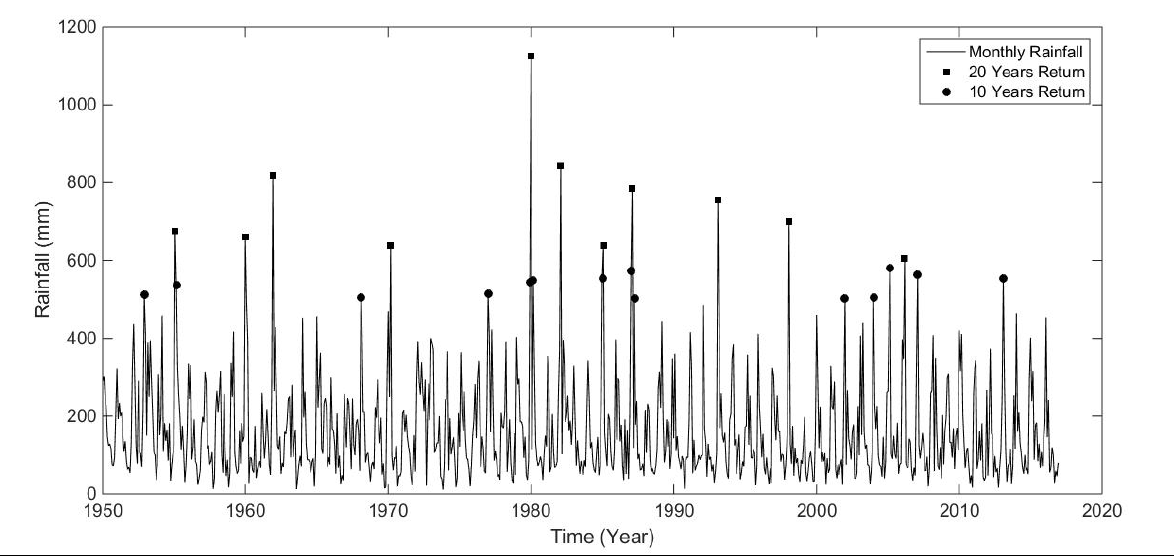
Figure 5: Monthly rainfall distribution and extreme events under 10- and 20-year return